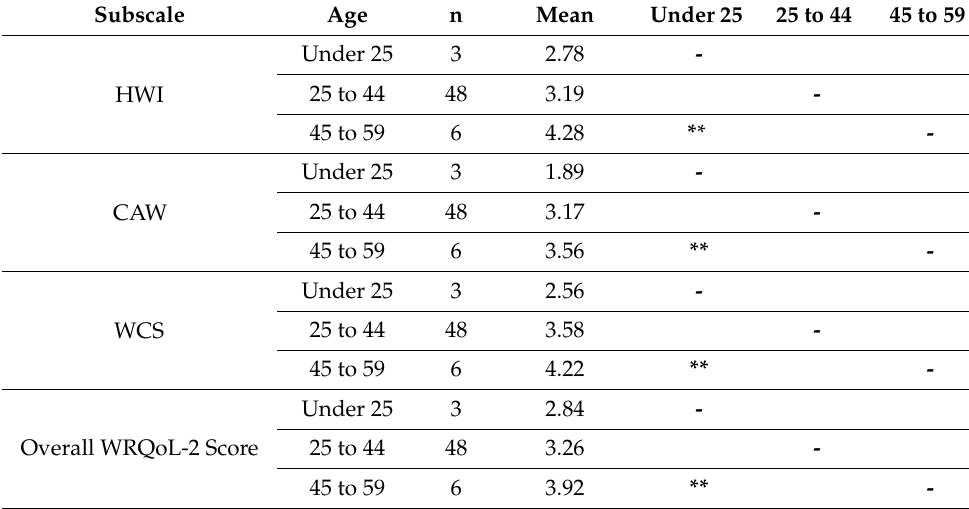
Table 7. Scheffe’s post ad hoc test for three subscales. Subscale